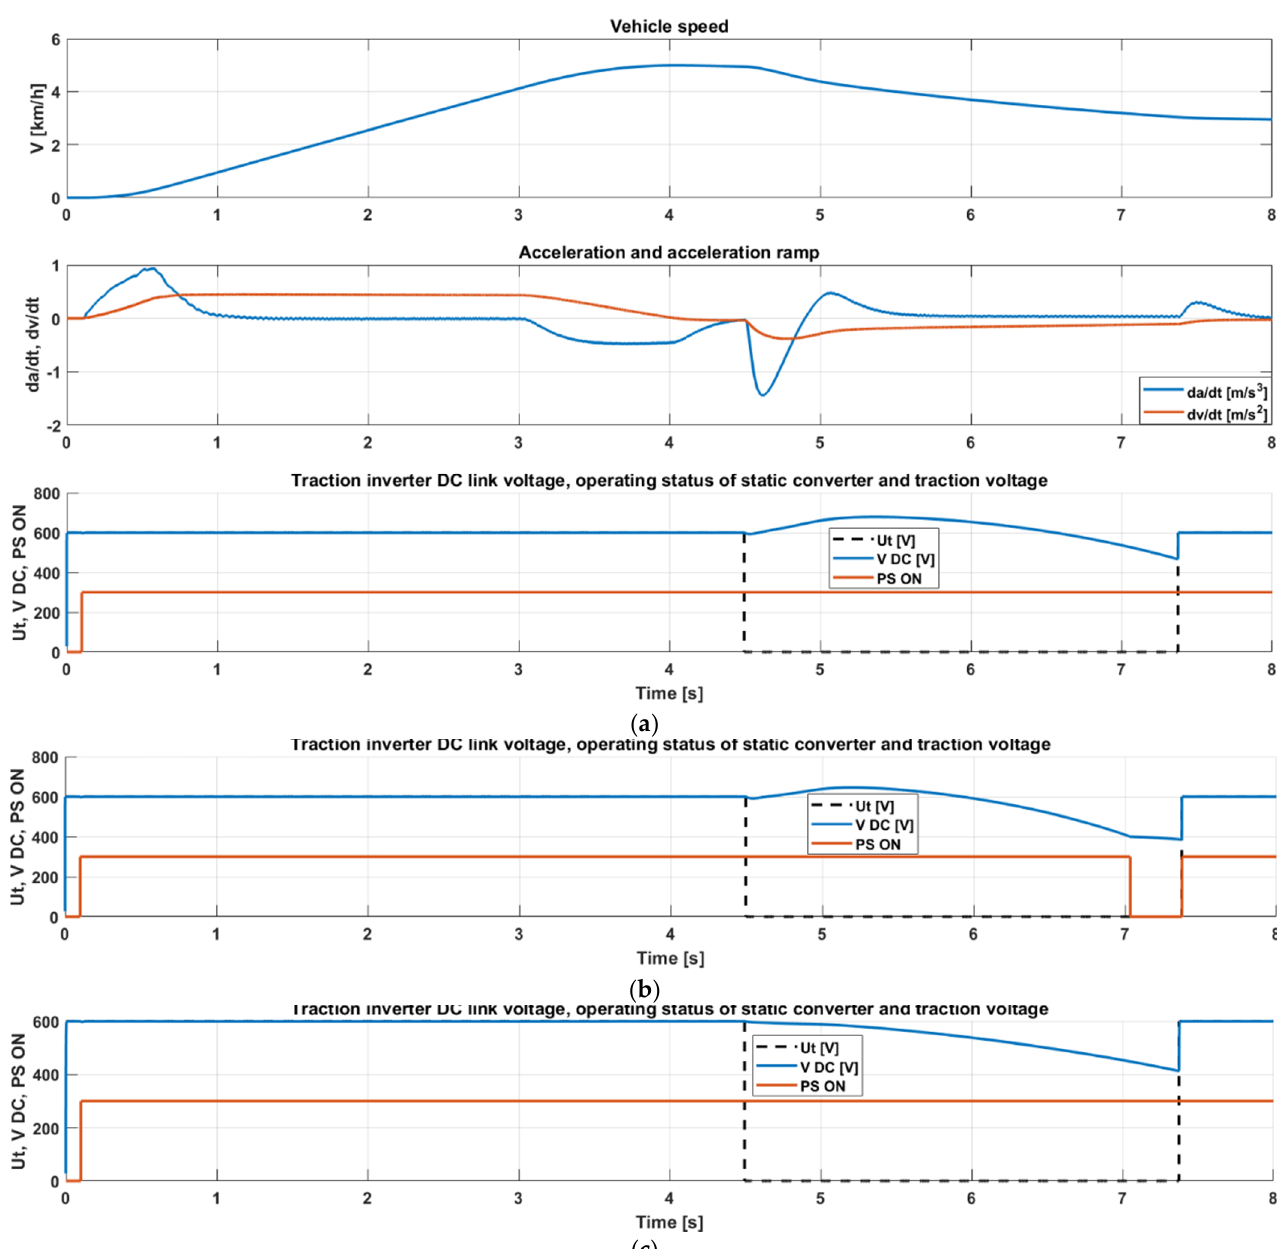
Figure 9. Simulation results for the initial speed of 5 km/h and loads of ( a ) 0.7 kW C d = 10 mF, ( b ) 1 kW C d = 10 m, and ( c ) 2.2 kW C d = 50 mF.